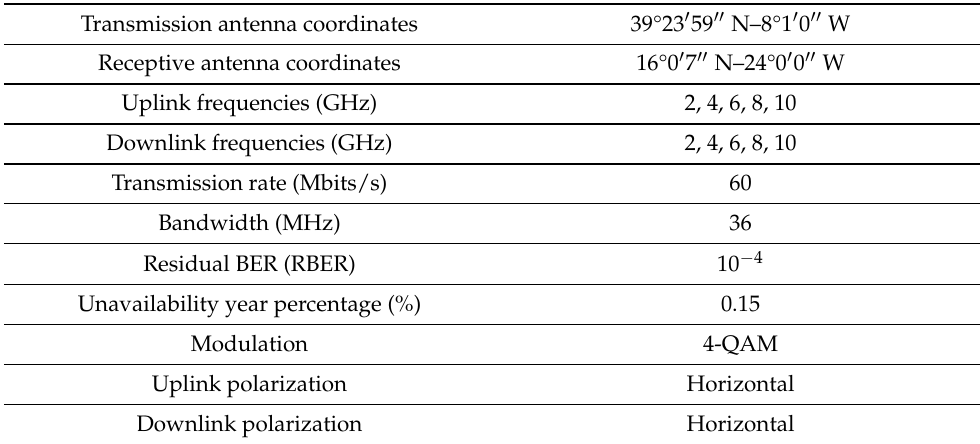
Table 9. Simulated satellite-link